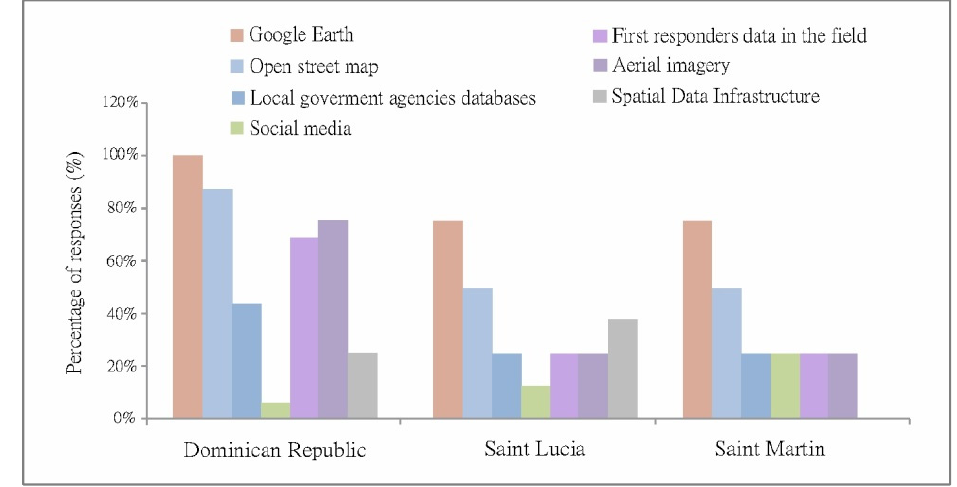
Figure 6. Utilization of data sources in EMT operations (Q20).